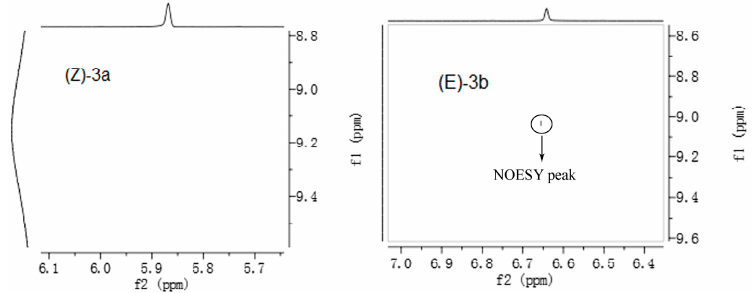
Figure 2. The coupling of C 4 -H and hydroxyl hydrogen in 1 H- 1 H NOESY spectra.